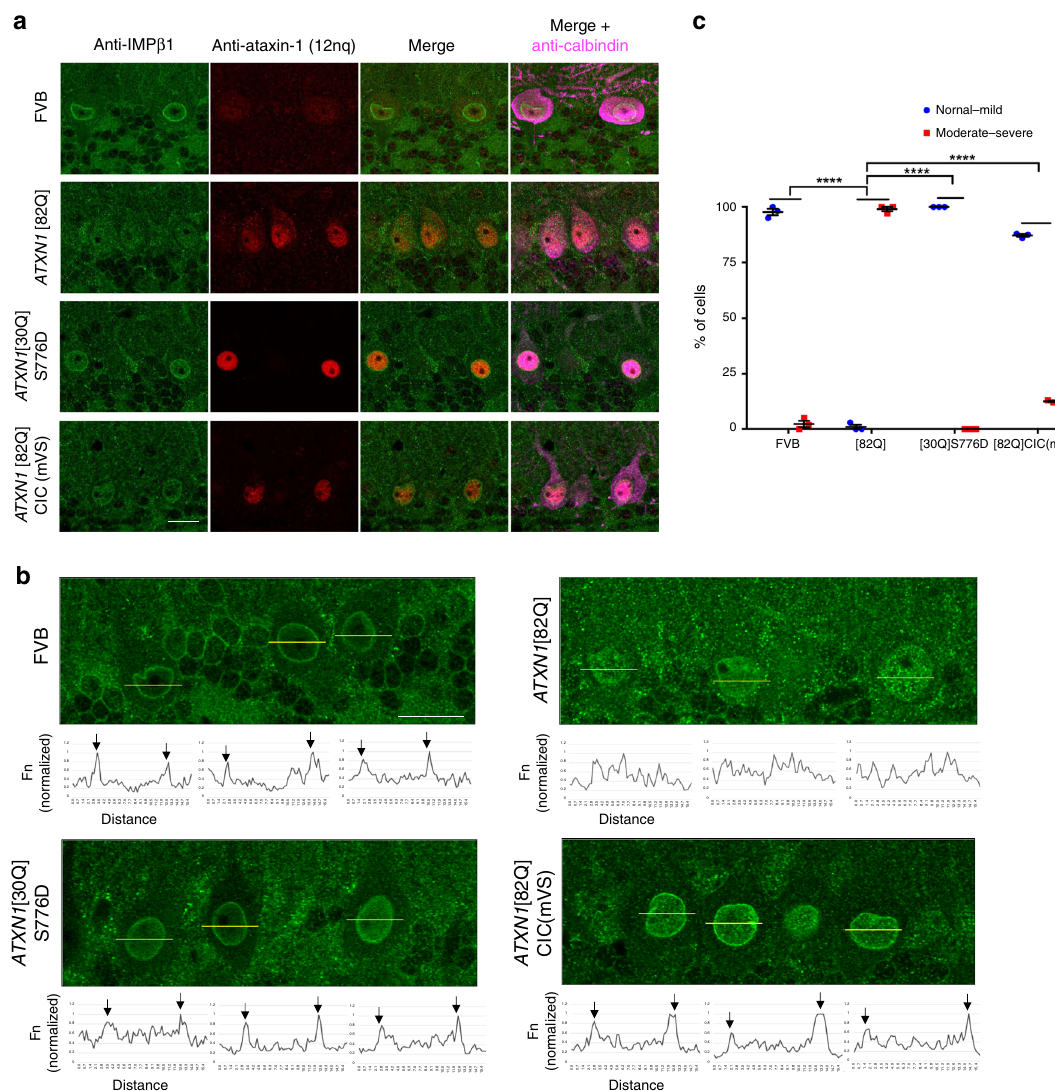
Fig. 6 Importin- β 1 is mislocalised in Purkinje cells in SCA1 mice. Mice (12 weeks old) of each genotype (FVB, ATXN1 [82Q], ATXN1 [30Q]S776D and ATXN1 [82Q]CIC(mVS)) were anaesthetised and cerebellum sections cut for staining and imaging. a IMP β 1 (green), ataxin-1 (red) and calbindin (magenta, a marker of Purkinje cells) were detected by immuno fl uorescent staining. Merge panels (IMP β 1 + ataxin-1 or IMP β 1 + ataxin-1 + calbindin) are shown. b Quantitative analysis of Purkinje cell IMP β 1 fl uorescence intensity in from each genotype; regions of the fl uorescence measurements are indicated by the yellow lines (upper panels) and fl uorescence intensity peaks are indicated by black arrows (lower panels). a , b Scale bars = 20 μ m. c IMP β 1 staining was scored as normal-mild (strong nuclear rim staining indicated by 2~3 fl uorescence peaks corresponding to nuclear rim by line scan measurement by Fiji), or moderate-severe (weak nuclear rim staining indicated by irregular fl uorescence peak distribution across the nucleus) by an observer blinded to the animal genotype; results were calculated as the percentage of Purkinje cells of each type. Results represent the mean ± SEM calculated using the following numbers of analysed cells in mice: FVB n = 161 cells from 3 mice, [82Q] n = 171 cells from 3 mice, [30Q]S776D n = 179 cells from 3 mice, [82Q] CIC(mVS) n = 106 cells from 3 mice, p value (both “ normal – mild ” and “ moderate – severe ” ) FVB vs [82Q] < 0.00001, [82Q] vs [30Q]S776D < 0.00001, [82Q] vs [82Q]CIC(mVS) < 0.00001 (**** p < 0.0001, two-way ANOVA and Tukey ’ s multiple comparisons test). Source data are provided as a Source Data fi dependent protein kinase as a mediator of phosphorylation and toxicity of ataxin-1 22 , it is of interest that we identi fi ed both regulatory and catalytic subunits of cAMP-dependent protein kinase in our interactome analysis (Supplementary Data 1).